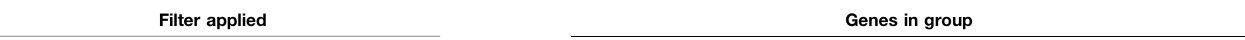
TABLE 1 | Number of genes for each factor meeting combinations of fi lters. Filter applied Genes in group Probabilistic Count |FC| DC HYP Coregulation Interaction p < 0.05 None None 5,392 6,181 2,660 1,288 p < 0.05 > 250 None 2,804 3,413 1,516 692 q < 0.05 None None 4,048 5,145 1,682 4 q < 0.05 > 250 None 2,128 2,915 1,001 4 q < 0.05 > 250 > 1.5 122 377 29 NA q < 0.05 > 250 > 2 29 104 7 NA Coregulation indicates signi fi cance for both DC and HYP